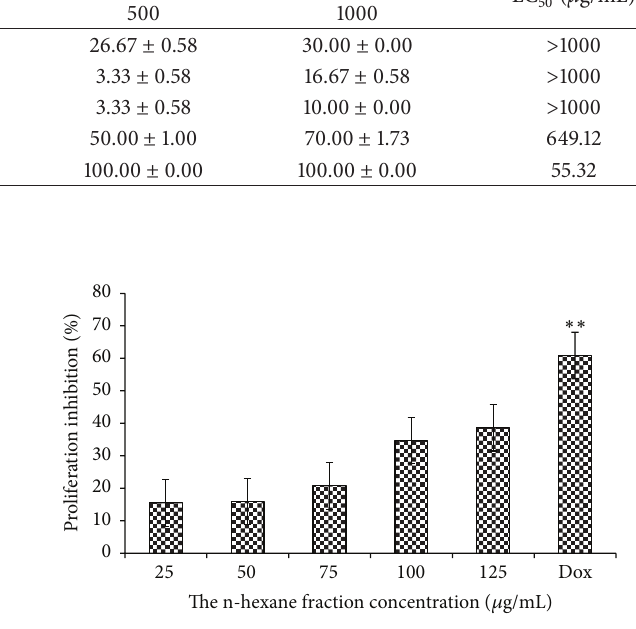
Table 1: Cytotoxic activity of D. pentandra leaves extracts and fractions against brine shrimps. Sample